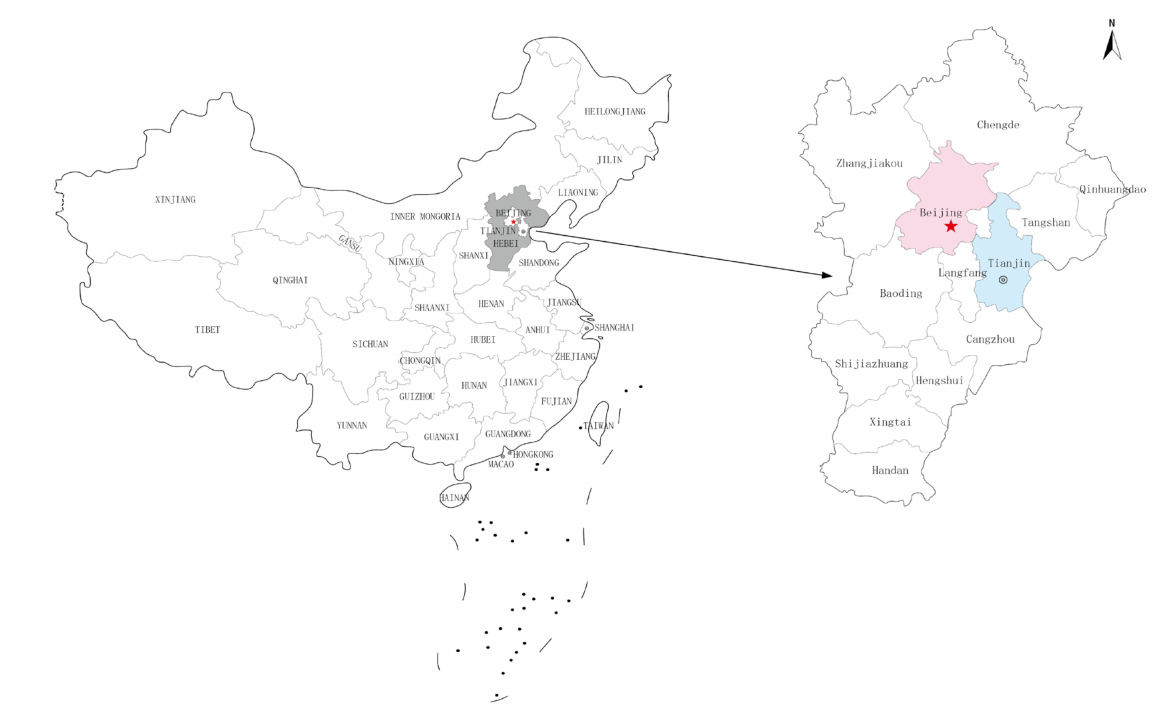
Figure 3. Location map of Beijing-Tianjin-Hebei Region.